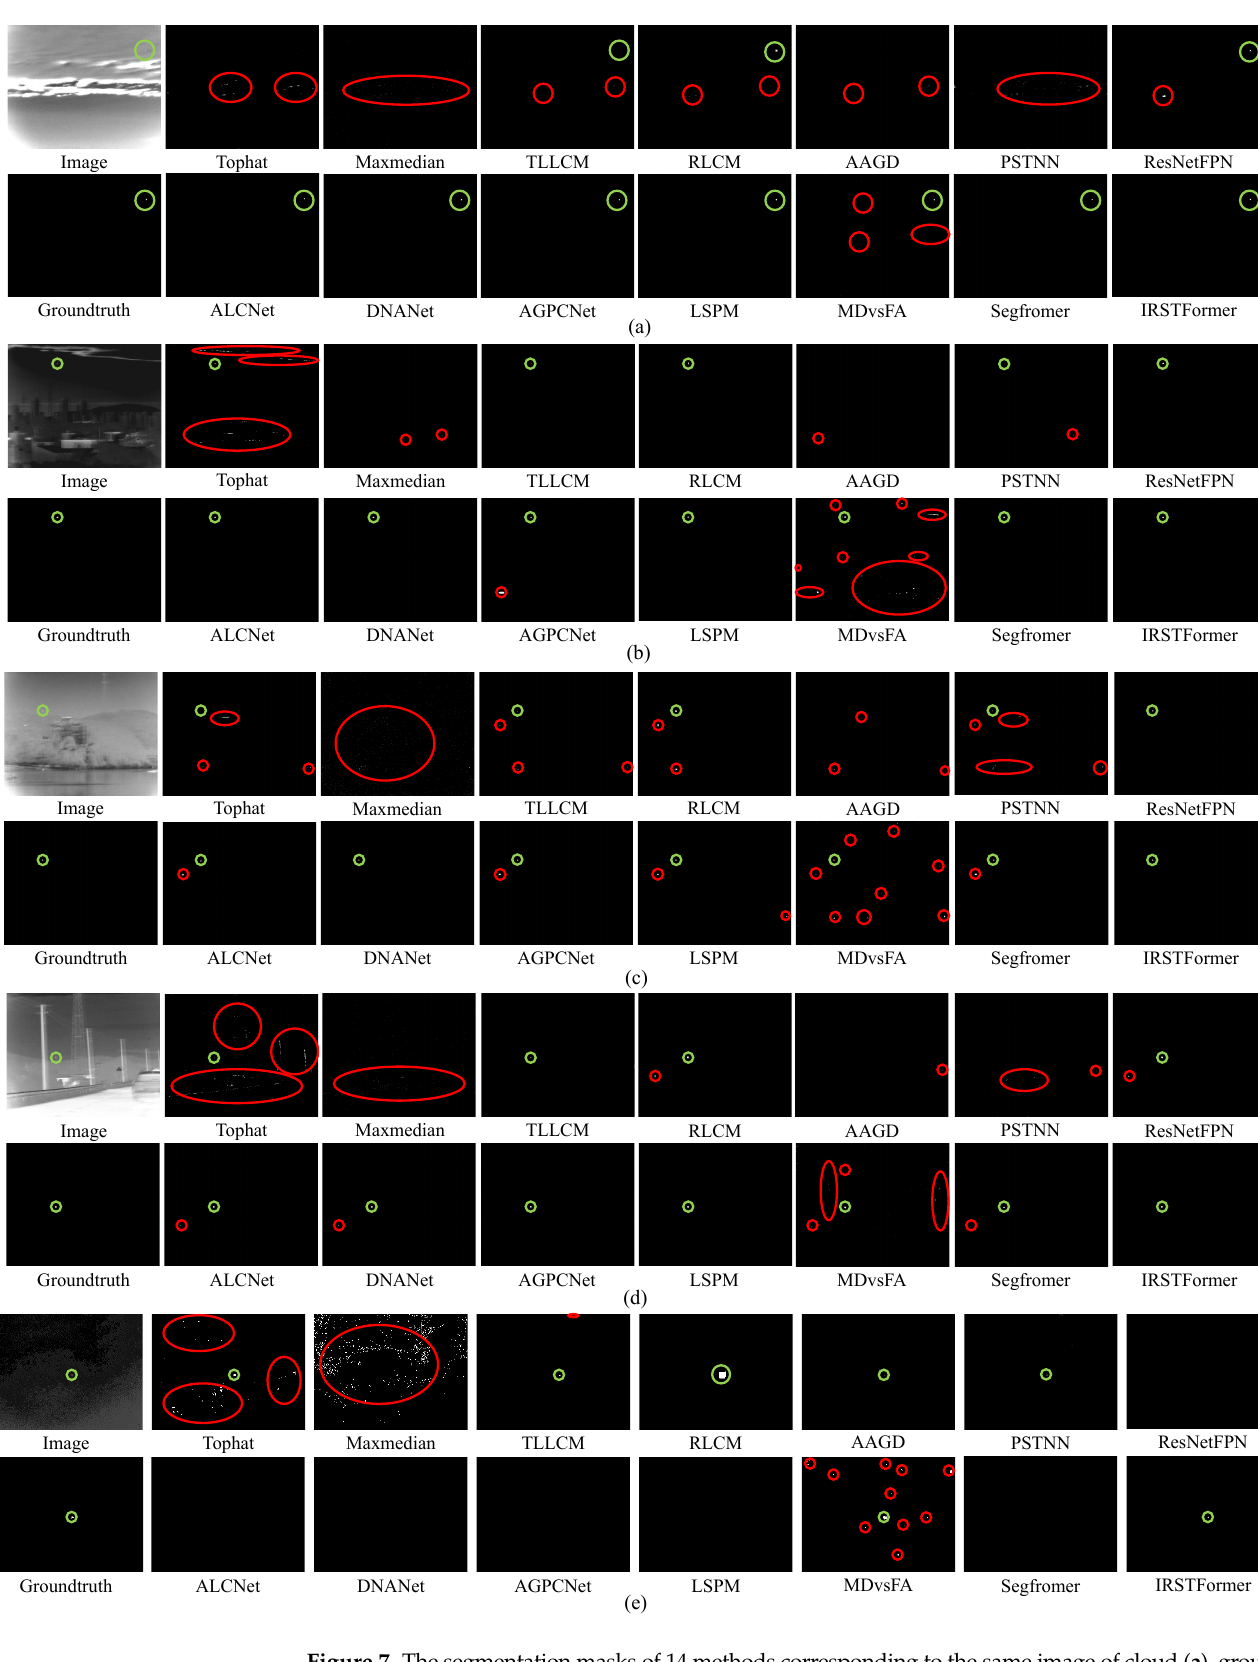
Figure 7. The segmentation masks of 14 methods corresponding to the same image of cloud ( a ), ground ( b – d ), and noisy pixels ( e ) scene. The green and red circle is the detected target and false alarm,